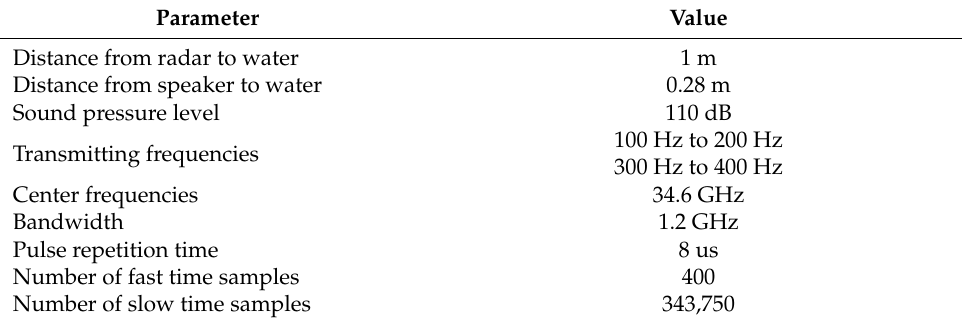
Table 1. Parameters of the cross-media communication.